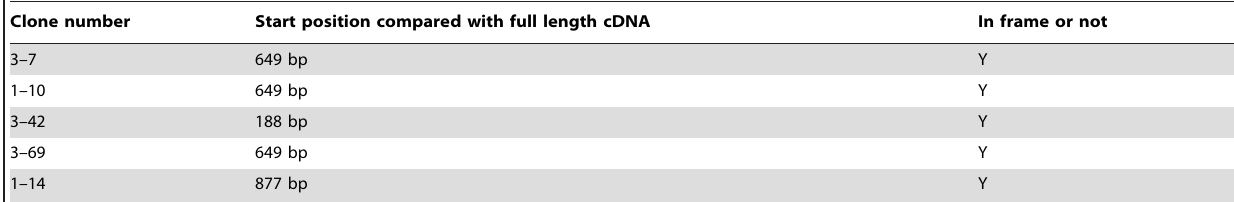
Table 1. ZmTaxilin clones identified by yeast two-hybrid.